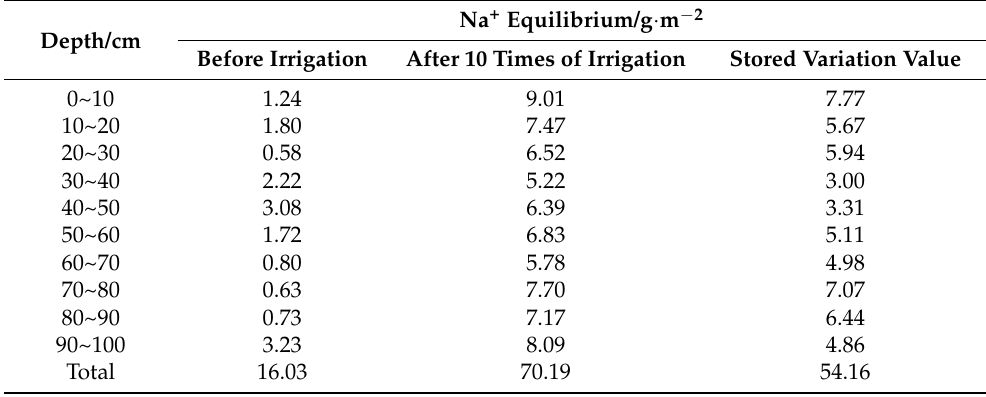
Table 3. Na + equilibrium calculation at different depths of typical